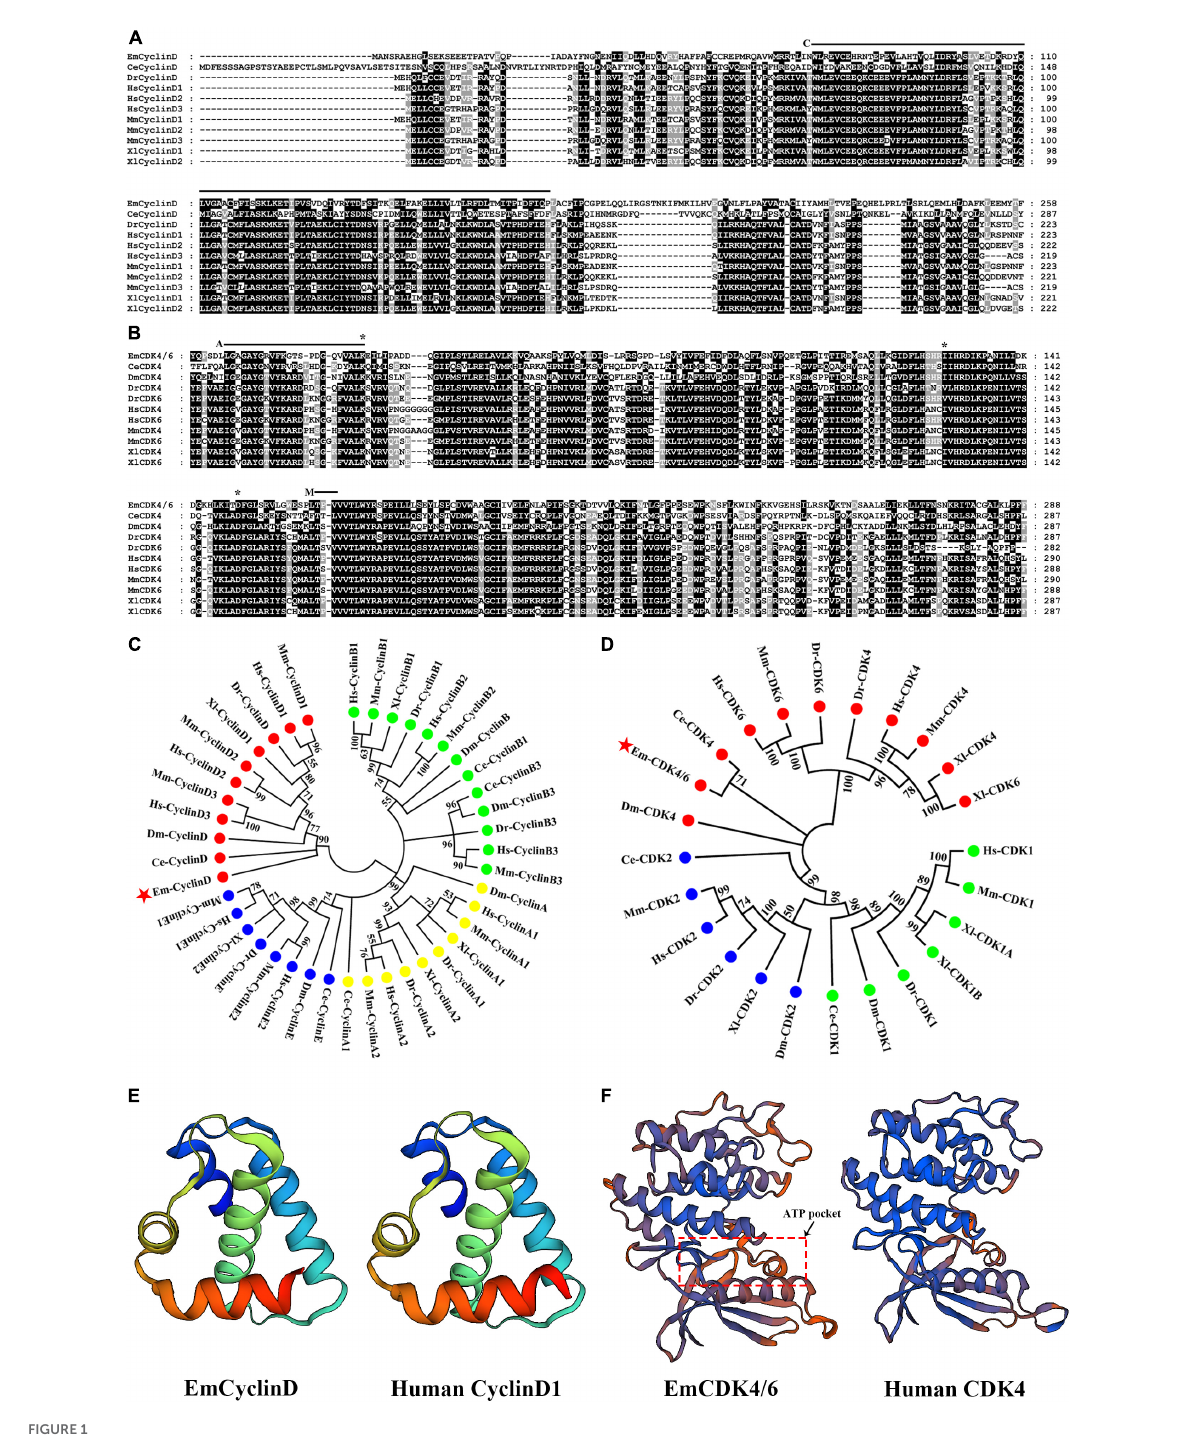
FIGURE1 Identification of CyclinD and CDK4/6 homologs in E. multilocularis . (A) Alignment of EmCyclinD with other established CyclinD members. The Cyclin box domain is marked with “C.” (B) Alignment of the S_Tkc domain of EmCDK4/6 with that of other CDK4 or 6 members. The ATP binding site is marked with “A,” the phosphorylation motif is marked with “M” and predicted Palbociclib binding sites are marked with “*.” (C,D) Phylogenetic analysis of EmCyclinD and EmCDK4/6 (marked with red stars). The full-length sequence of CyclinD members and the S_Tkc domain of CDK4/6 members were used for phylogenetic tree construction. Em, Echinococcus multilocularis ; Ce, Caenorhabditis elegans ; Hs, Homo sapiens ; Mm, Mus musculus ; Dm, Drosophila melanogaster ; Dr, Danio rerio ; Xl, Xenopus laevis . (E) Comparison of the predicted three-dimensional structures of the Cyclin box of human CyclinD (UniprotKB code P24385) and EmCyclinD. (F) Comparison of the predicted three-dimensional structures of the S_Tkc domain of human CDK4 (UniprotKB code P11802) and